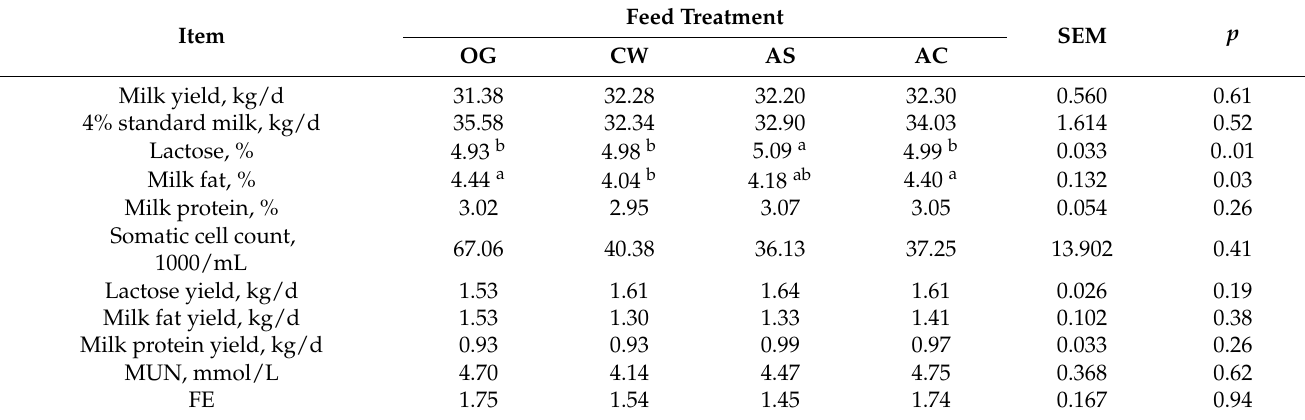
Table 5. Effects of TMR with different forage sources on milk yield and milk